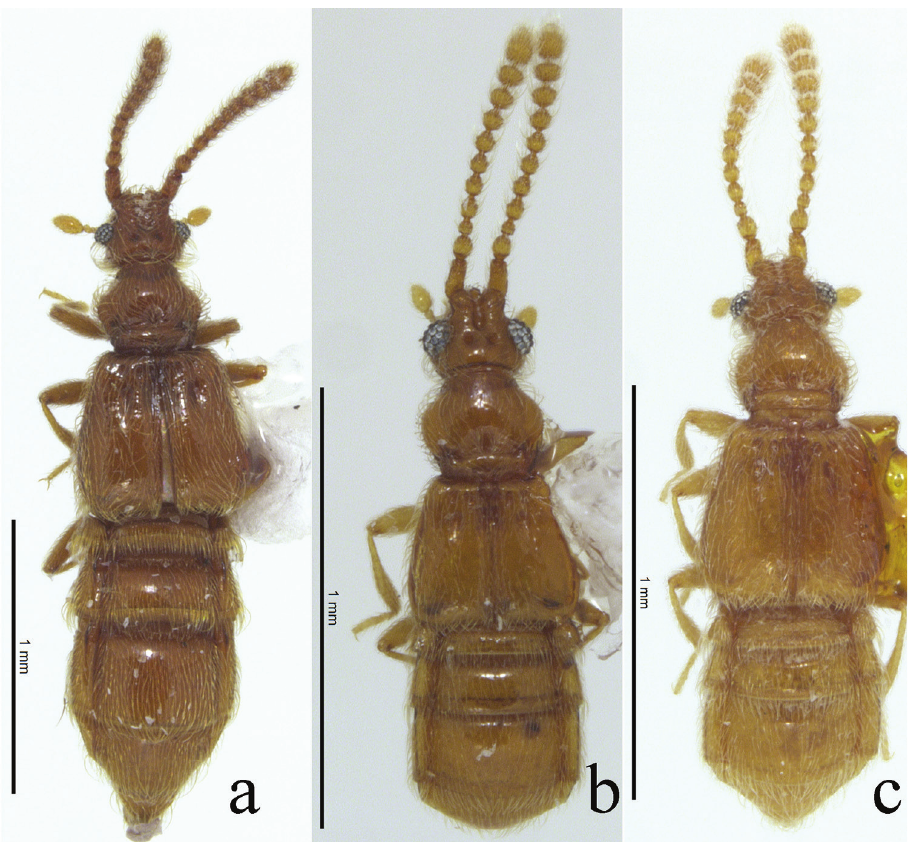
Figure 1. Habiti, dorsal view. a Nornalup afoveatus sp. n. b N. quadratus sp. n. c N. minusculus sp. n. Scale bars: 1